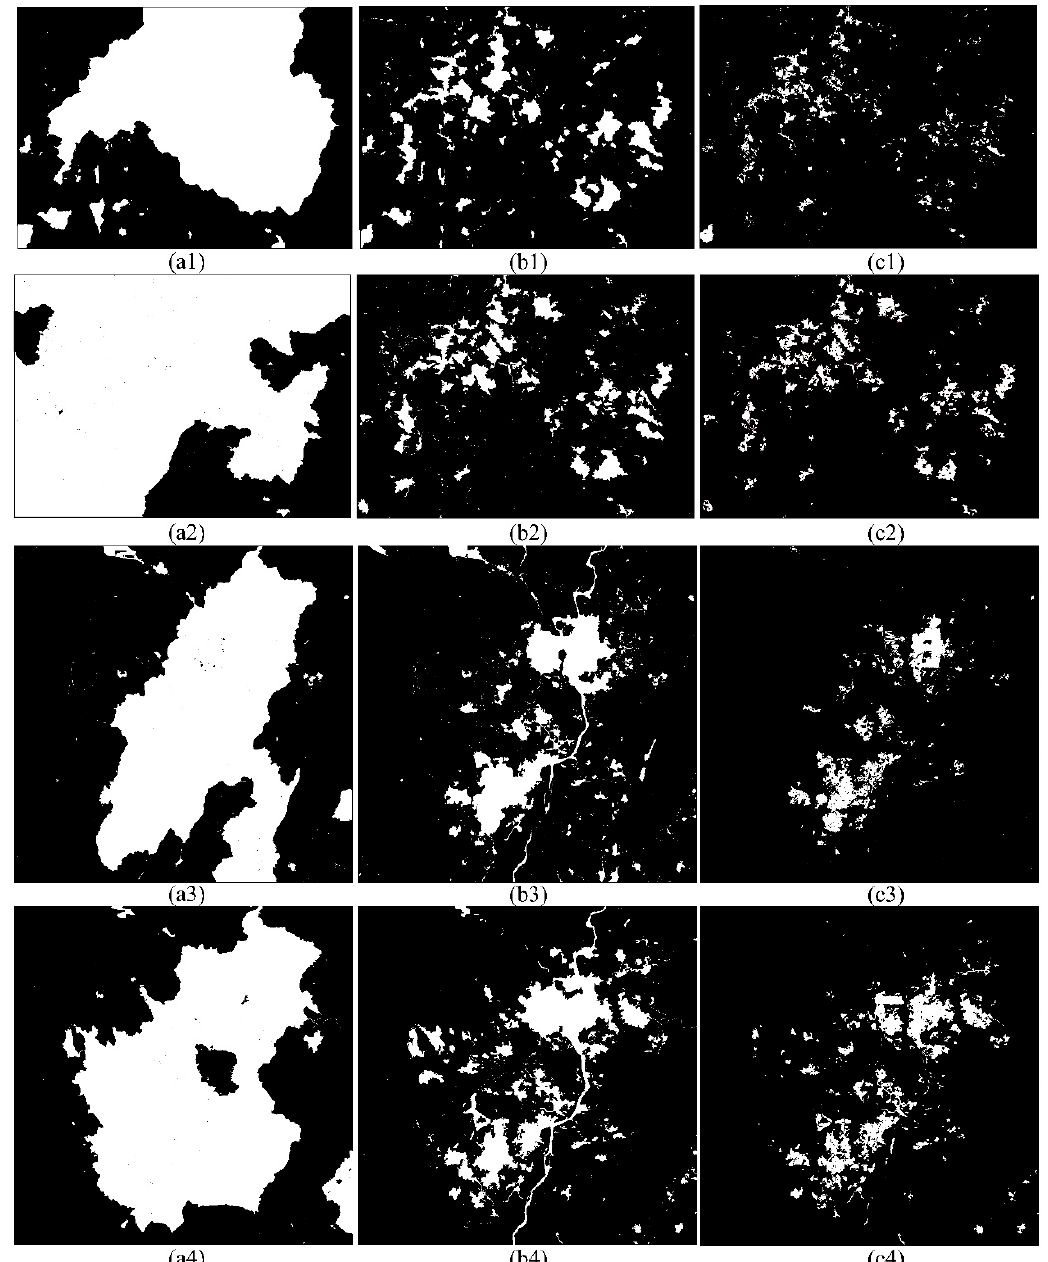
Figure 7. REO mining area extraction results with different methods. ( a1–c1 ) Results of GF-1 images in Lingbei; ( a2–c2 ) results of ALOS images in Lingbei; ( a3–c3 ) results of GF-1 images in Shipai; ( a4–c4 ) results of ALOS images in Shipai; ( a1–a4 ) results of the normal GrabCut method with self-drawing rectangles as initial inputs; ( b1–b4 ) results of the original GrabCut method with the salient region as the initial input; ( c1–c4 ) results of the proposed method. Table 2. Accuracy of REO mining area extraction with various methods in different study areas.